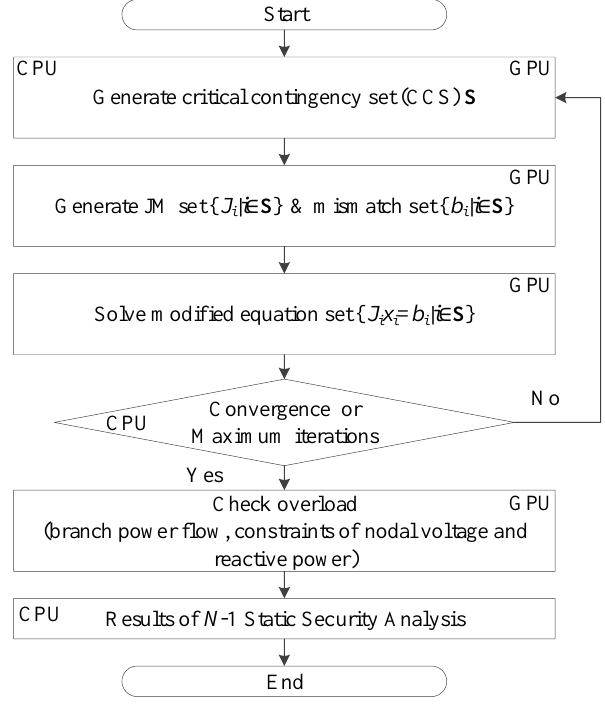
Figure 4. Framework of the proposed method in